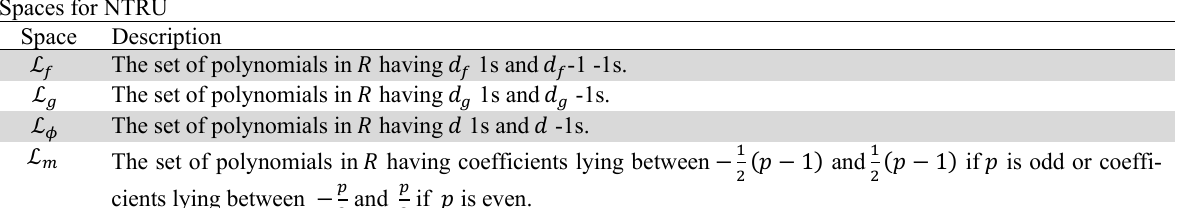
Spaces for NTRU